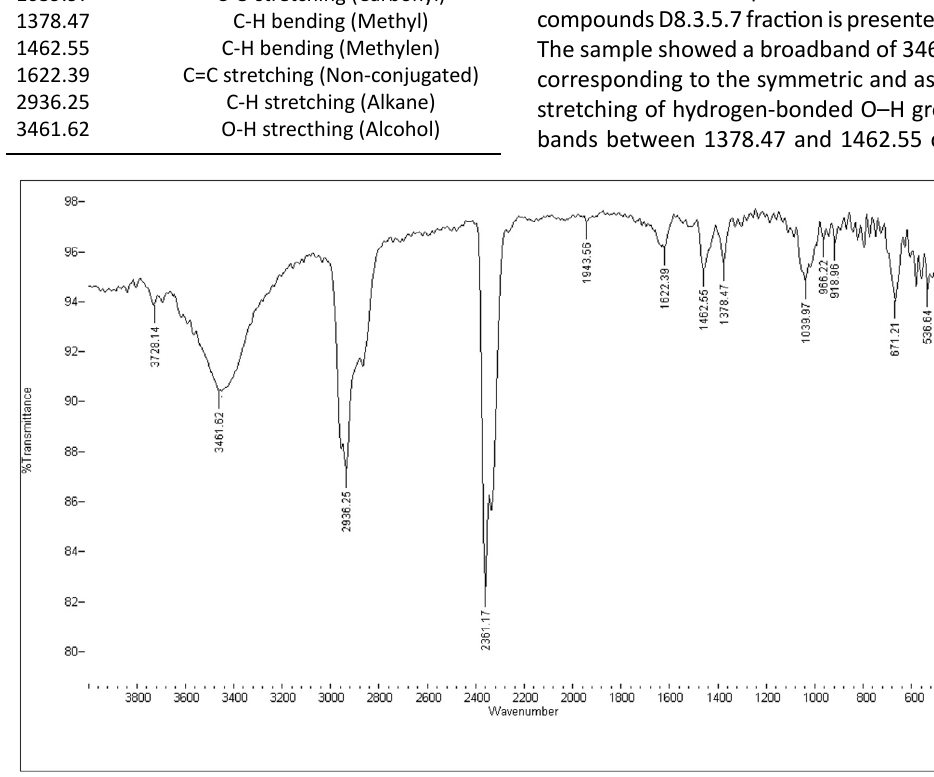
Fig. 6. FTIR spectrum of isolated compounds of D8.3.5.7